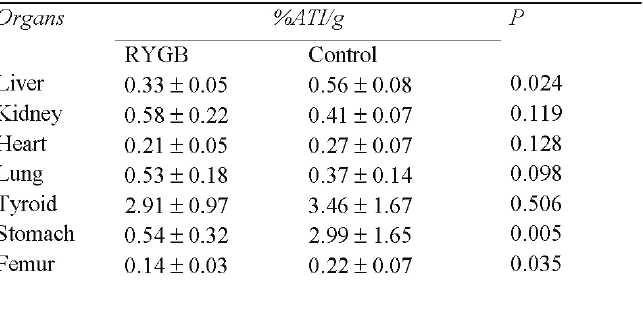
TABLE 1 - Percentage of radioactivity (% ATI/g) of each organ sample in animals submitted to Roux-en-Y gastric bypass and